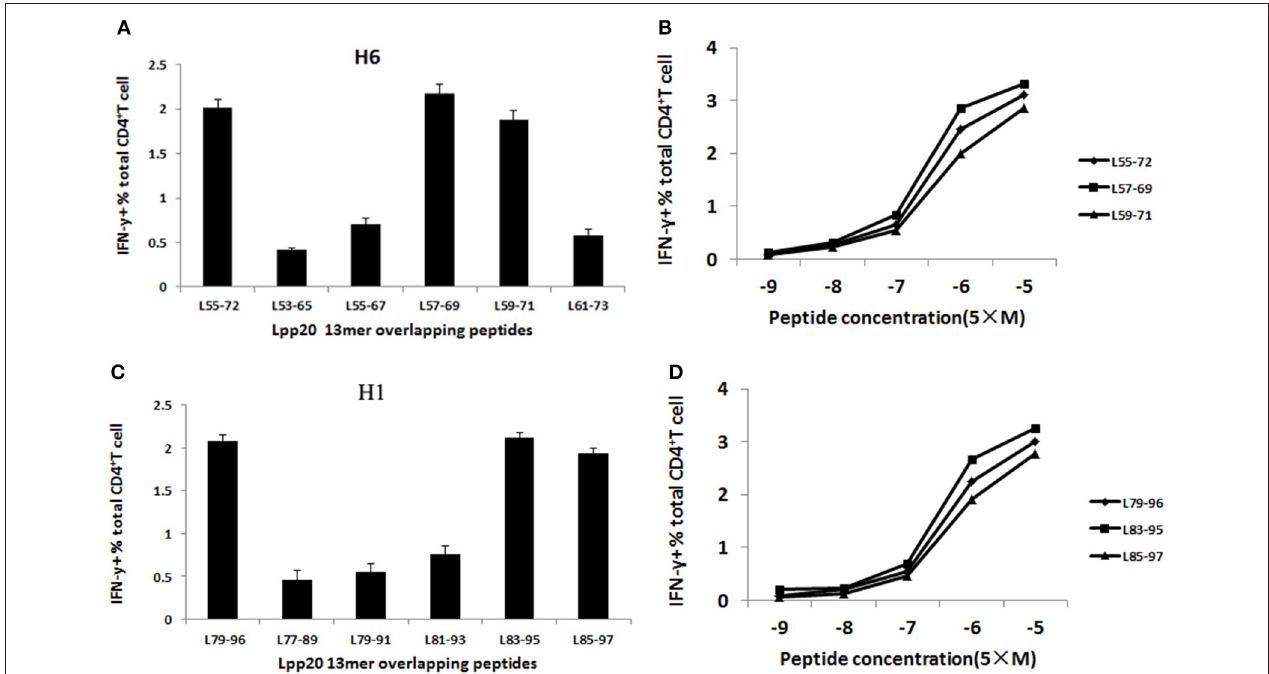
FIGURE 4 | The identification and characterization of the core sequence of L 55 – 72 and L 79 – 96 immunodominant epitope. Lpp20-specific T cells from subject H1 and H6 were expanded in vitro as described above. The cells were screened for their specific response to the 5 Lpp20 13mer overlapping peptides (final concentration ∼ 5 µ mol/L) in an ICS assay. (A) The 13mer overlapping peptides within the L 55 – 72 18mer epitope were screened with L 55 – 72 specific T cells. (B) The 13mer overlapping peptides within the L 79 – 96 18mer epitope were screened with L 79 – 96 specific T cells. (C) Three of the reactive peptide L 55 – 72 , L 57 – 69 , and L 59 – 71 were titrated to compare their activity. (D) Three of the reactive peptide L 79 – 96 , L 83 – 95 , and L 85 – 97 were titrated to compare their